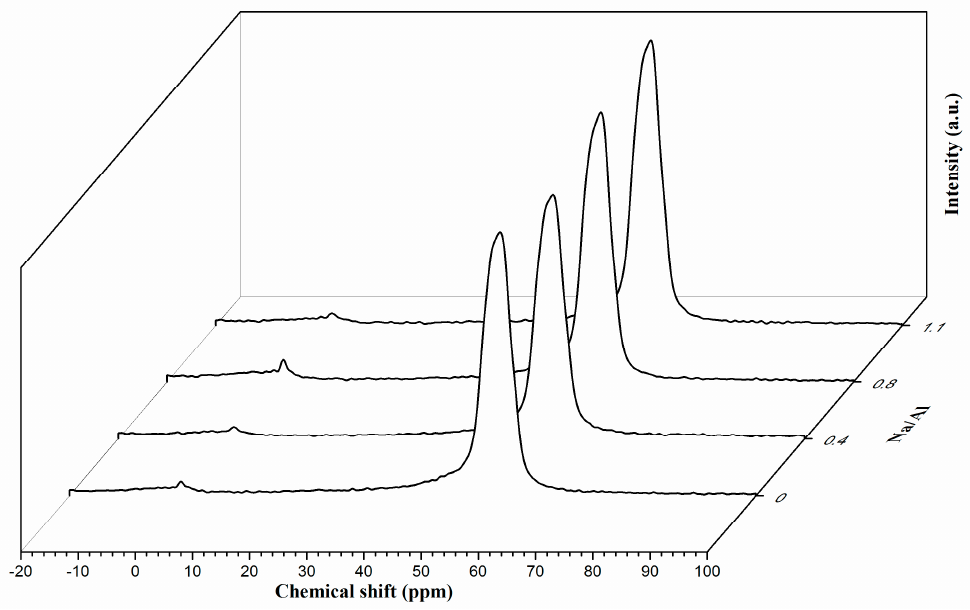
Figure 3. 27 Al-MAS NMR spectra of HZ(0), HZ(0.4), HZ(0.8) and HZ(1.1) catalysts.